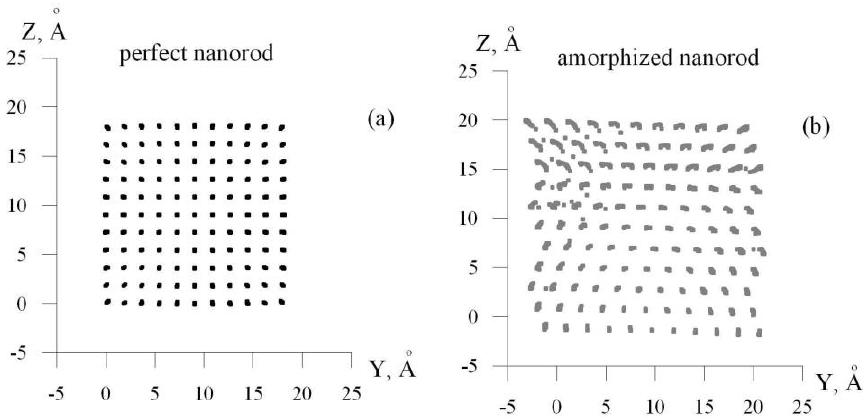
Fig. 2. View of the perfect (a) and amorphized (b) nanosized rod in the YZ plane.